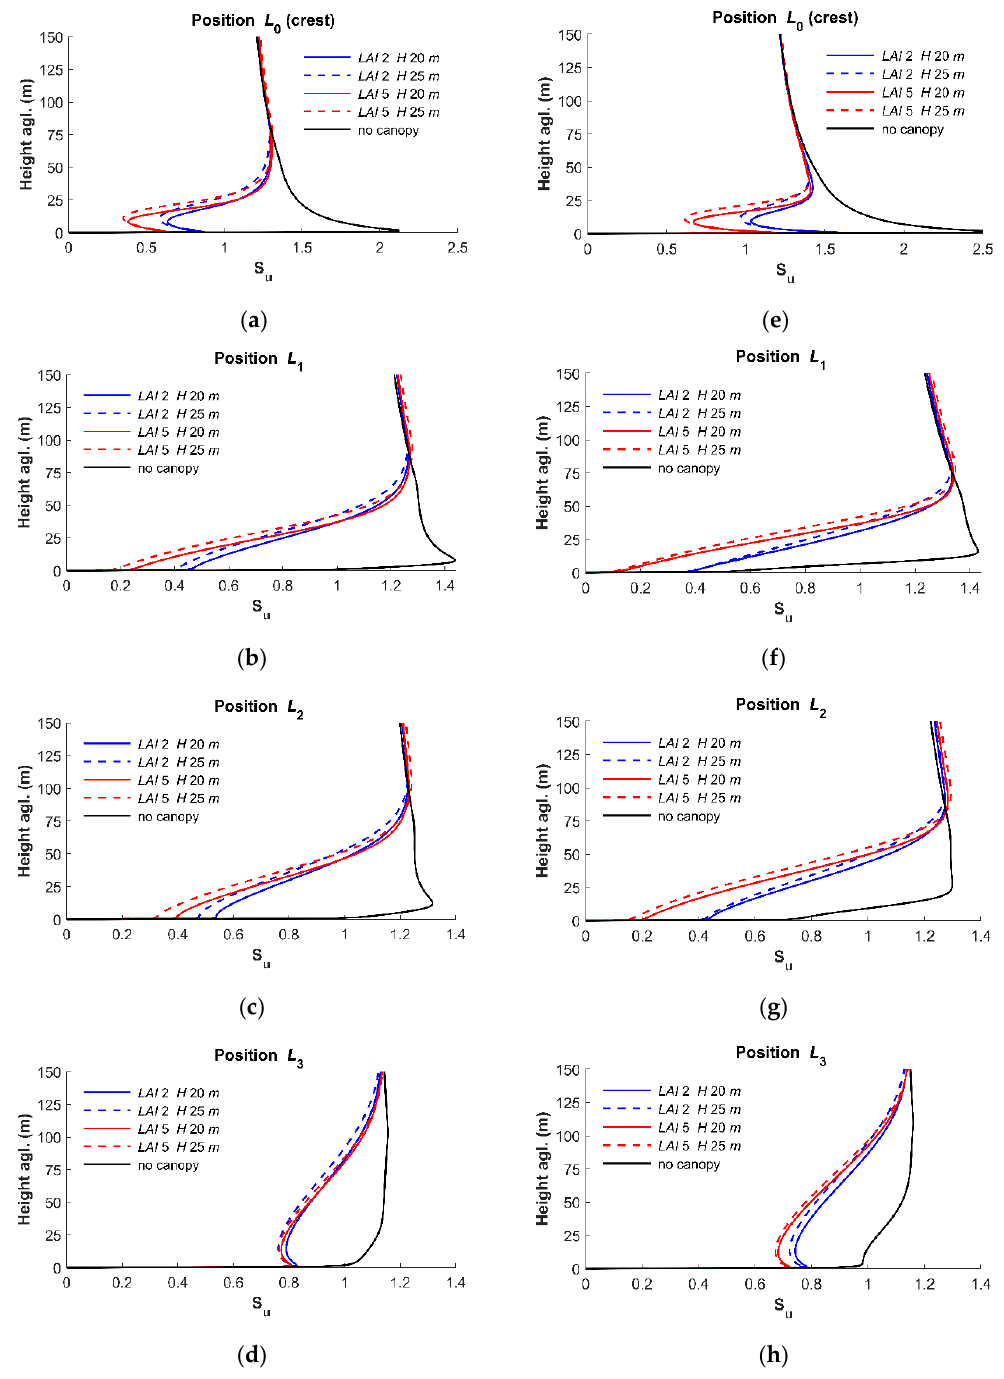
Figure 4. Speed-up profiles for the horizontal velocity at L 0 , L 1 , L 2 and L 3 position for an angle of 15 ◦ ( a – d ) and 30 ◦ ( e – h ). The red and blue curves are the simulation results with an LAI of 2 and 5, respectively. The solid and dashed lines indicate a forest height of 20 m and 25 m, respectively.